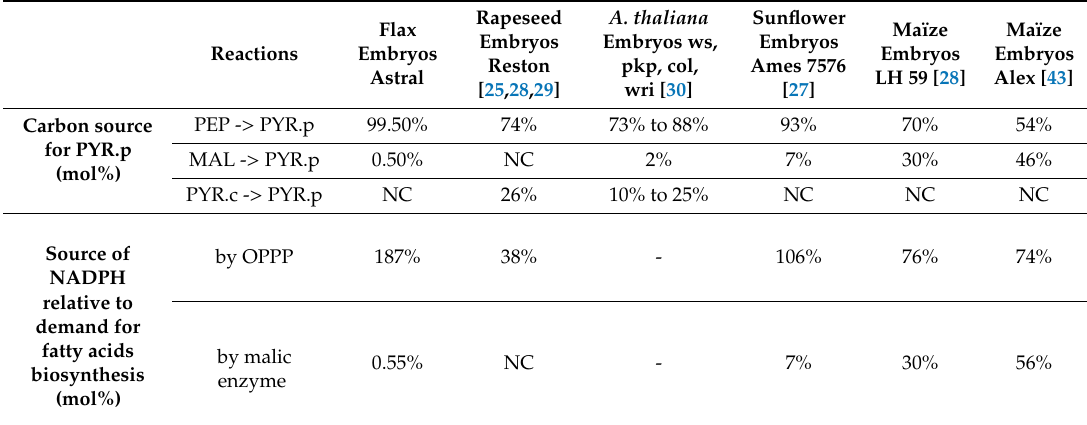
Table1. ComparisonofcarbonsourceforPYR.pandNADPHbetweenflax, rapeseed, Arabidopsisthaliana , sunflower and maize cultivated developing embryos during lipid biosynthesis and accumulation calculated from 13C-MFA analysis.